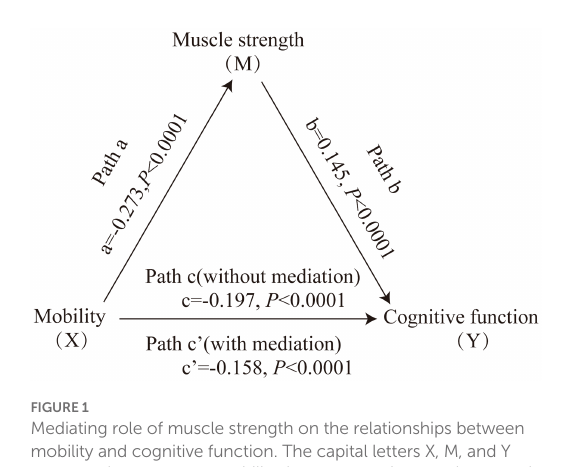
FIGURE 1 Mediating role of muscle strength on the relationships between mobility and cognitive function. The capital letters X, M, and Y were used to represent mobility, lower extremity muscle strength and cognitive function, respectively. The mediating effect tested the four following pathways (regression coefficients): mobility on muscle strength (Path a), muscle strength on cognitive function (Path b), mobility on cognitive function without medication (Path c), mobility on cognitive function with medication (Path c’).